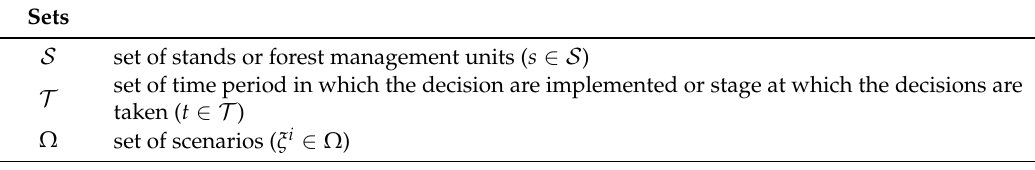
Table 1. Variable, set and parameters used in problem